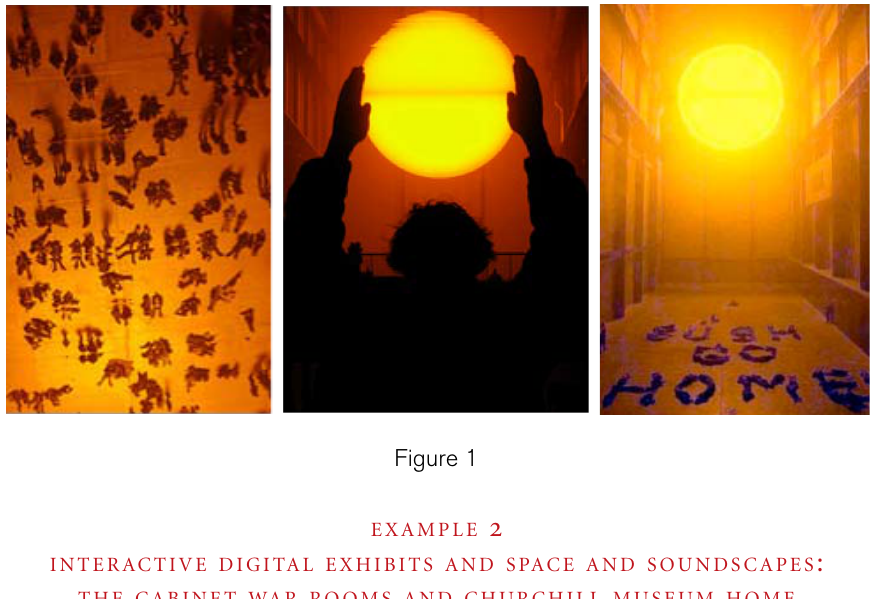
Figure 1 example